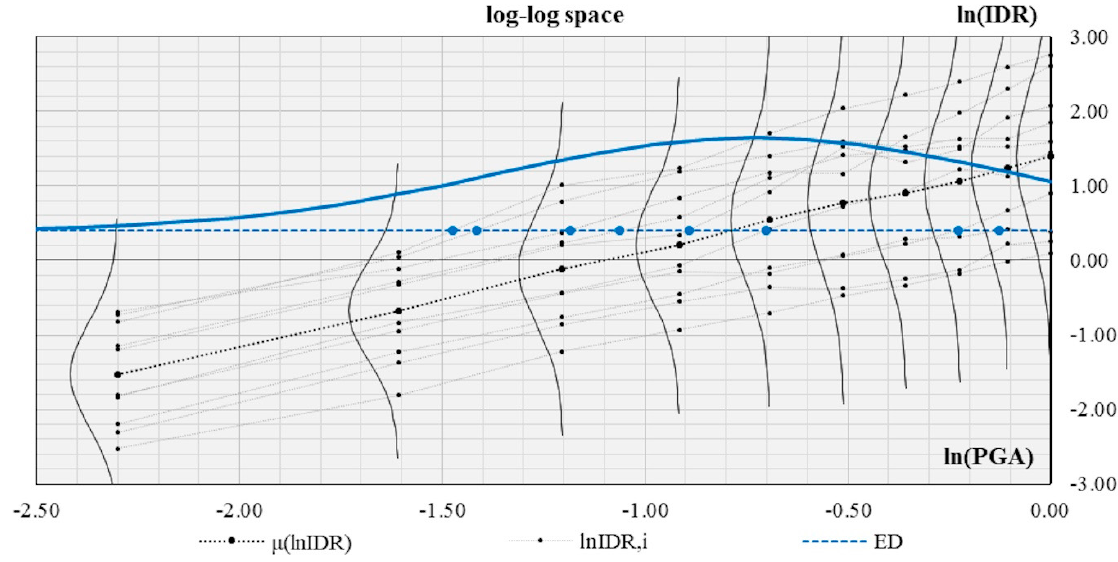
Figure 15. ln IDR,i values in log–log space and their corresponding PDFs and ED PDF.